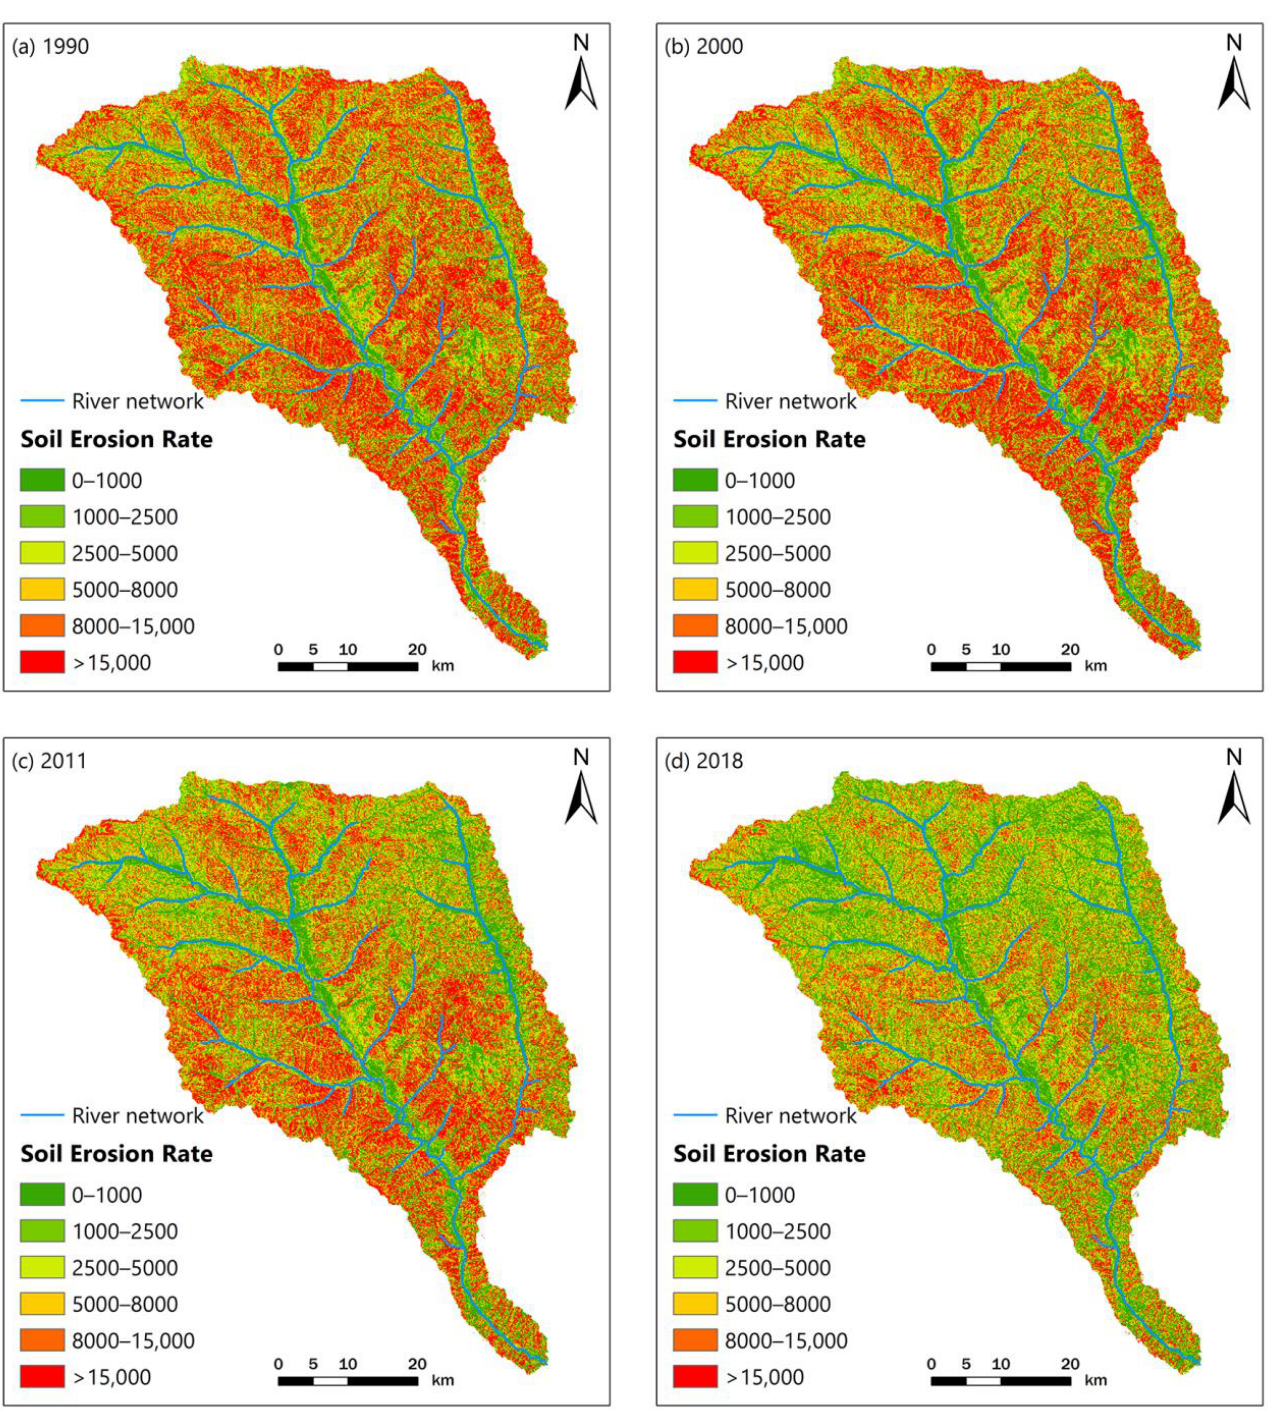
Figure 8. Soil erosion rate changes in the Huangfuchuan watershed (Unit: t km − 2 a − 1 ). ( a ) Soil erosion rate map in 1990. ( b ) Soil erosion rate map in 2000. ( c ) Soil erosion rate map in 2011. ( d ) Soil erosion rate map in 2018.